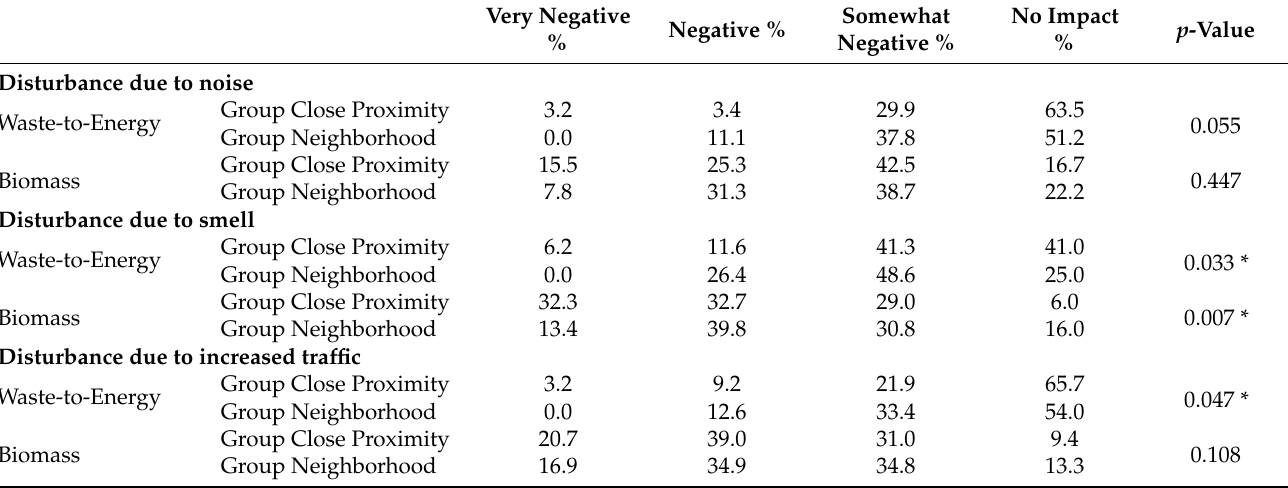
Table A2. Evaluation of experienced level of disturbance in the waste-to-energy and biomass neighborhoods—differentiation between people living close (Group Close Proximity) and the ones living further away (Group